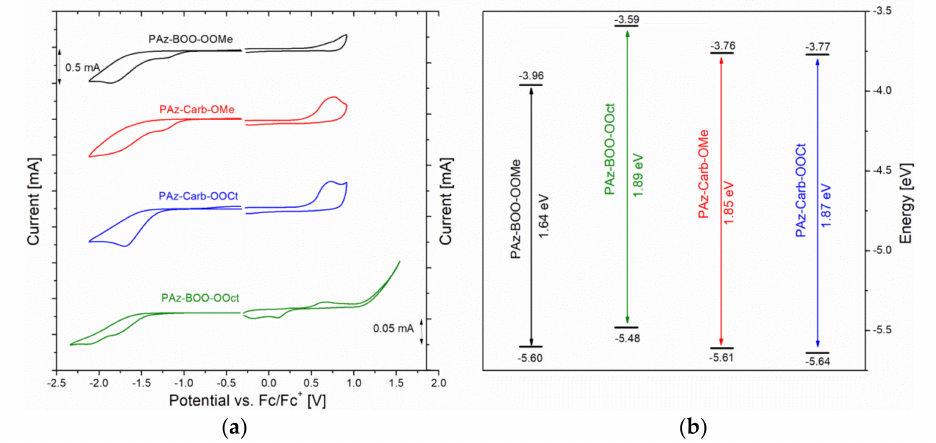
Figure 3. ( a ) Voltammograms, recorded during oxidation and reduction processes (v = 0.1 V/s; 0.1 M Bu 4 NPF 6 /ACN) of studied oligo- and polyazomethine thin films, deposited on the glass with ITO together with voltammogram obtain for PAz-BOO-Oct , presented previously in [11]; ( b ) the energy levels of HOMO and LUMO orbitals, designated based on the results of cyclic voltammetry